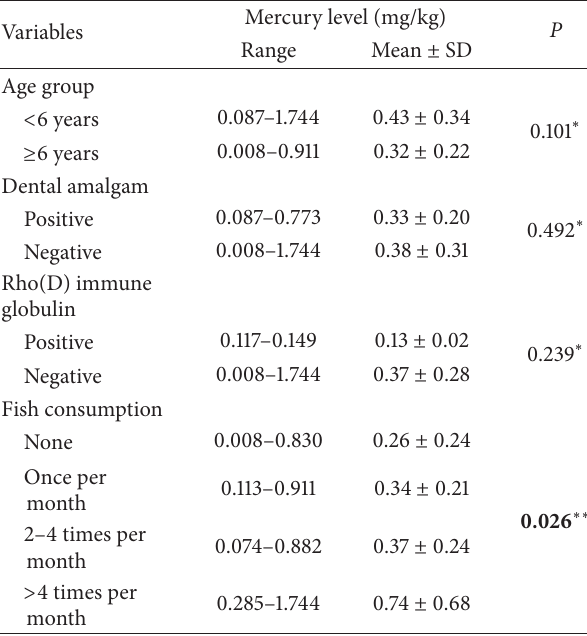
Table 5: The relationship between risk factors and lead level among